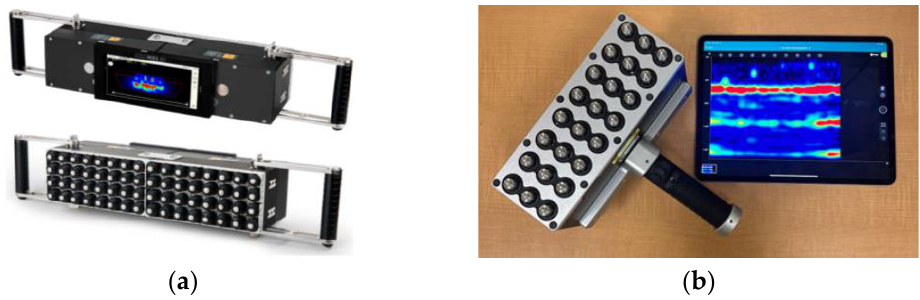
Figure 7. PAU test setup: ( a ) Line scan, ( b ) Stripe scan. GPR response or line views traversing perpendicular to bars embedded in each slab